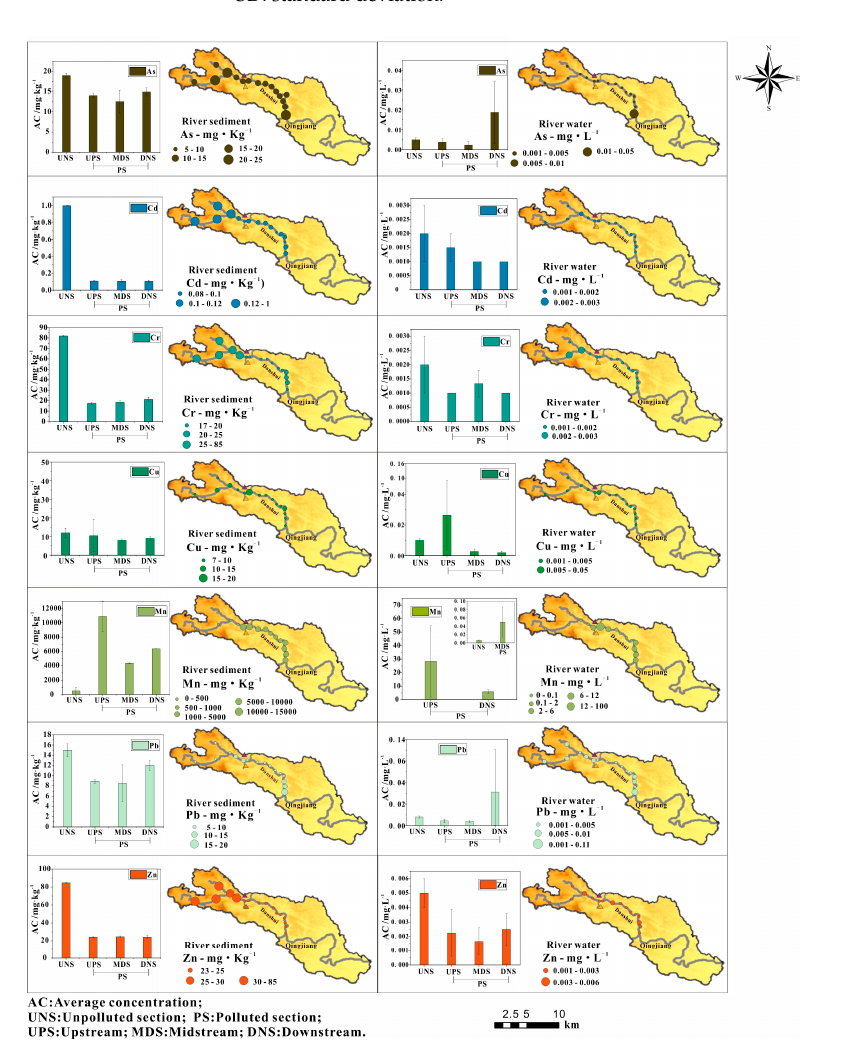
Figure 2. Distribution of PTEs in river water and sediments along the Danshui River in manganese mining area.